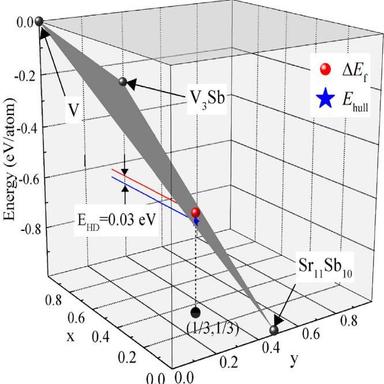
The formation energy of VxSbySr1xy as a function of chemical composition (x,y). The dark shaded area shows the convex hull that is determined by the plane passing through the three phase points corresponding to the stable phases of the constituent elements that VSbSr can decompose into, i.e. Sr11Sb10, V3Sb, and V, as extracted from the Open Quantum Materials Database (see text for more details).